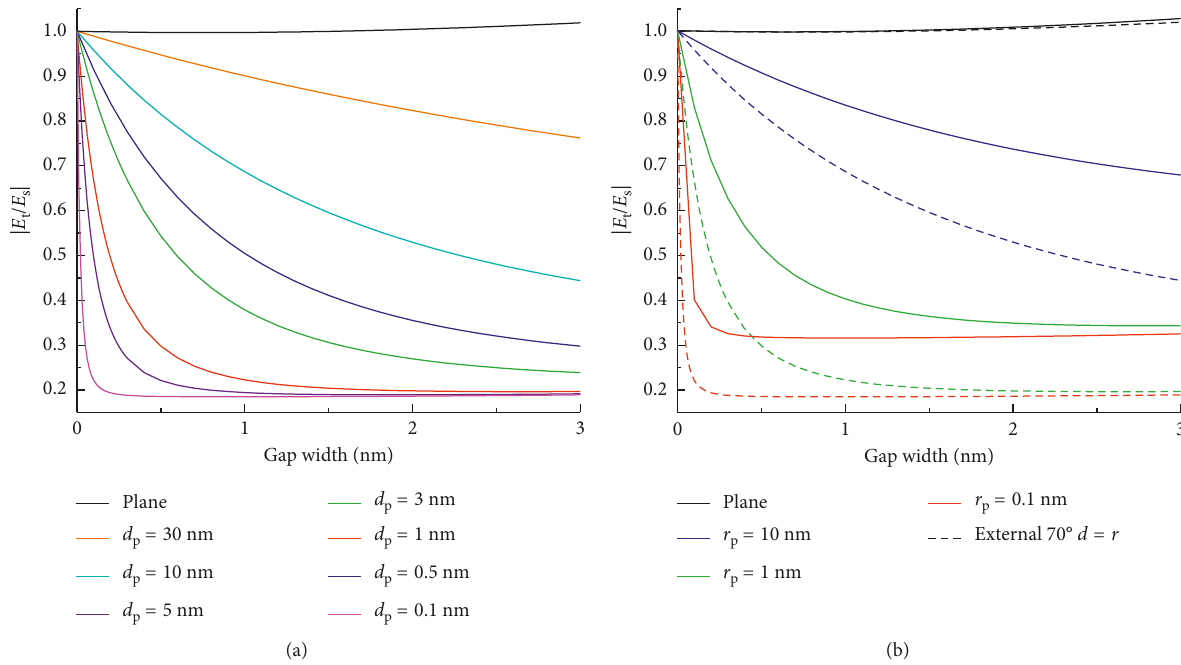
Figure 5: Dependencies of the ratio of fields at the tip apex and at the protrusion on the surface versus the distance between them for different sizes of the protrusion (a) and the comparison of the case of the external illumination with the case of tip-source [1]